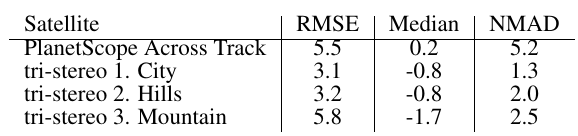
Table 1. Height difference statistics in m between LiDAR first return points and DSM for different AOIs in Catalonia. Note